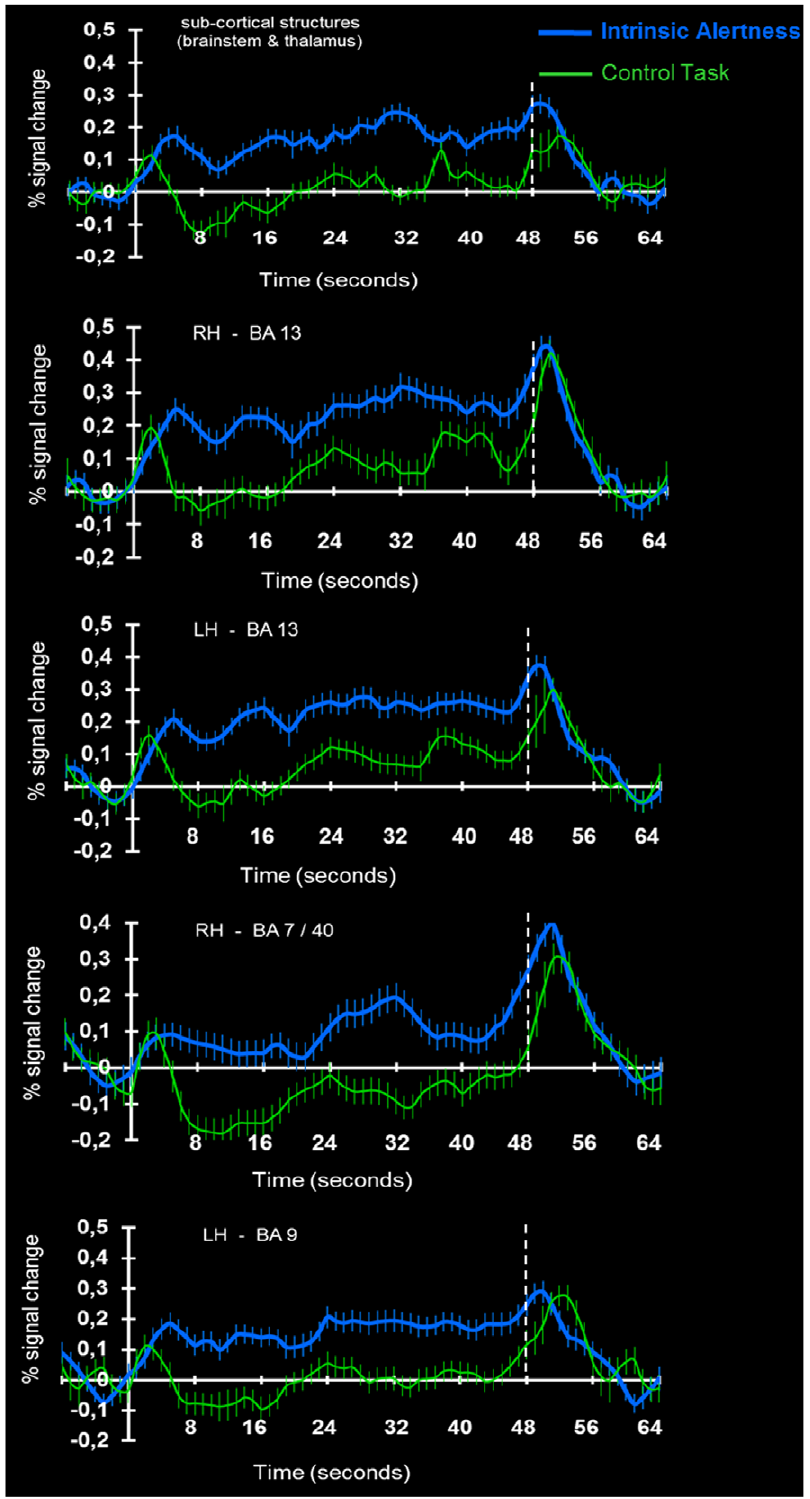
Figure 7. Averaged time course plots of the BOLD response during intrinsic alertness- and control task. Averaged time course plots of the BOLD response during the intrinsic alertness task and the control task, relative to the low-level baseline condition (fixation). For several clusters of interest, including sub-cortical and cortical structures, averaged time course plots illustrate the BOLD response, averaged across 16 participants, during both the intrinsic alertness task (blue line) and the control task (green line). Relative to the low-level baseline condition, the averaged time course plots depict the amount of signal change for both the intrinsic alertness- and the control task, during the whole experimental run. Error bars represent the SEM, averaged across all participants, and the dashed white line marks the end of the block. Time zero always corresponds to the beginning of the experimental block. (BA=Brodmann area; RH=right hemisphere; LH=left hemisphere) . doi:10.1371/journal.pone.0025453.g007 PLoS ONE |